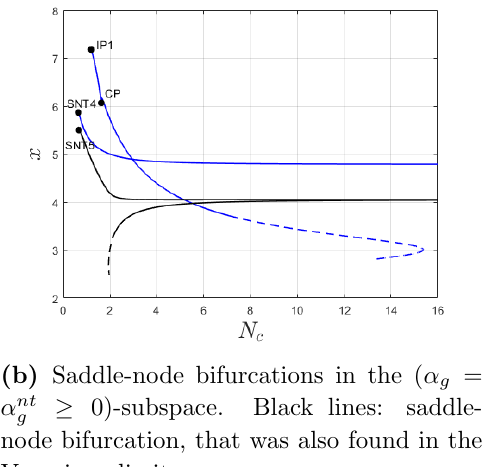
Black lines: saddle- node bifurcation, that was also found in the Veneziano limit.